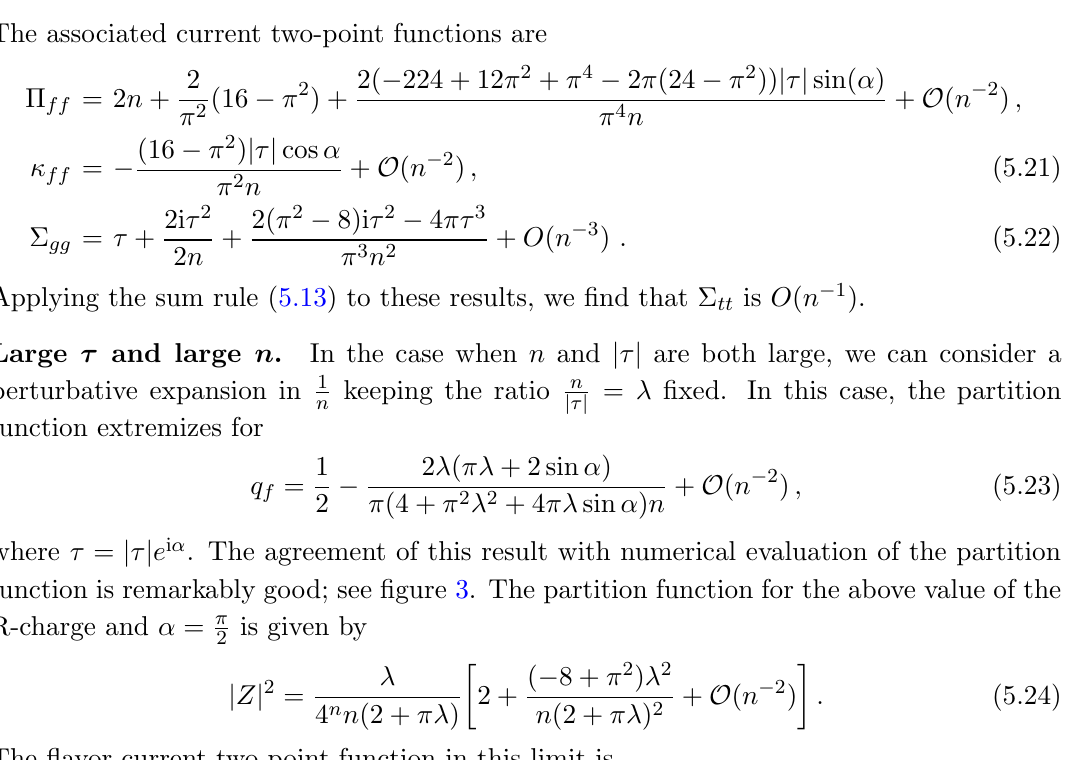
: (left) various values of (cid:21) and 2